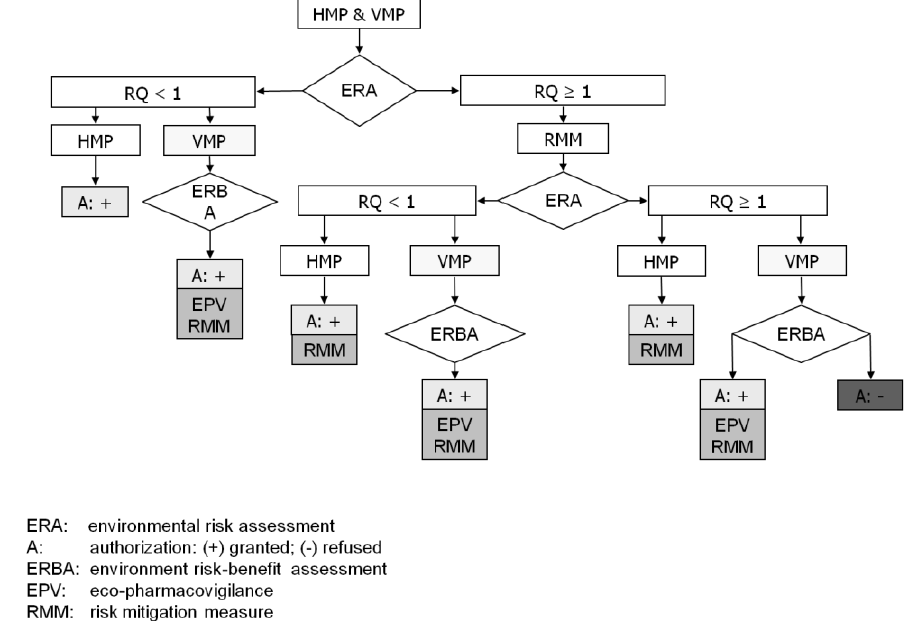
Figure 1. Schematic flow chart showing the options to apply risk mitigation measures as part of the evaluation of environmental concerns of human (HMP) and